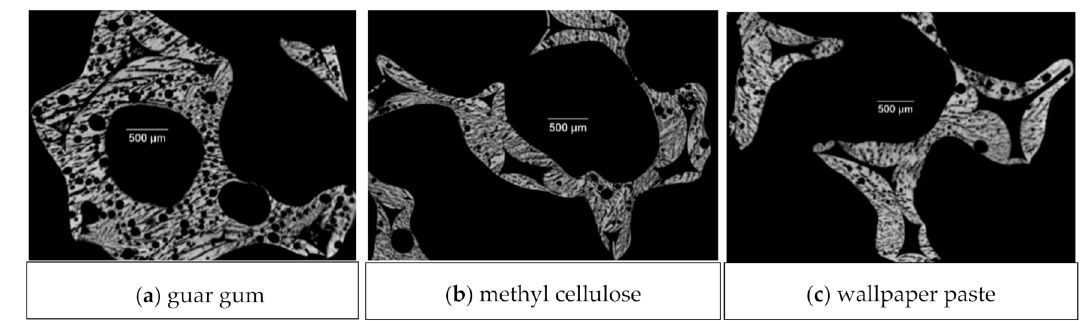
Figure 8. µ CT-Images of samples with 40 vol% solid content ( a ) guar gum, ( b ) methylcellulose, ( c ) wallpaper paste.3.2. Microstructure of Dried Samples (Coating Quality).